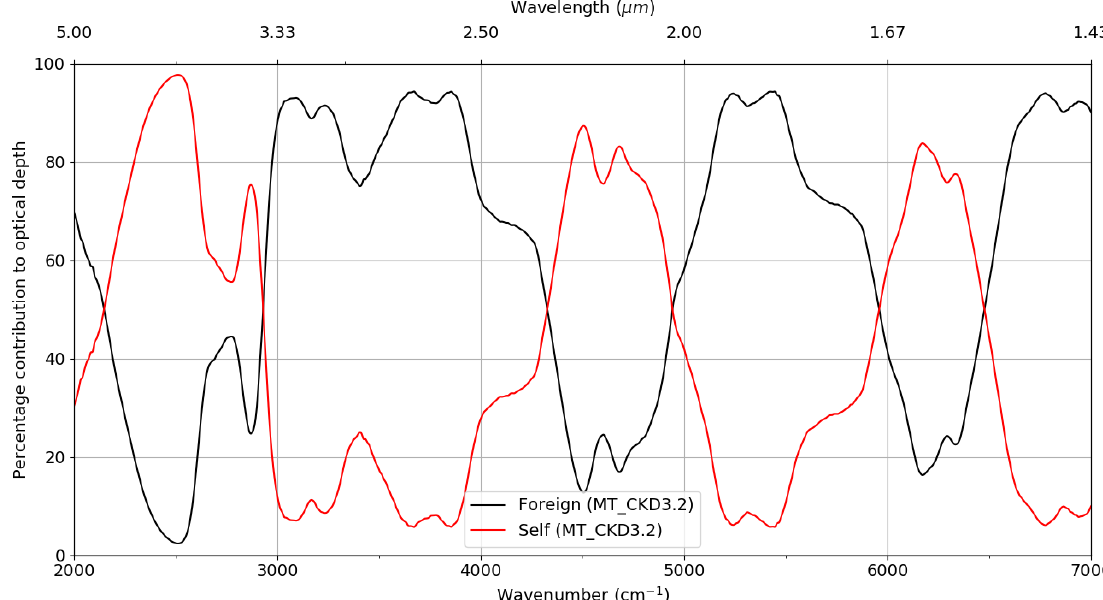
Figure 18. Proportion of the 18 September 2008 Camborne optical depth attributable to the self- and foreign-continua as calculated using the MT_CKD_3.2 model. The total optical depth is shown by the red line in Fig. 7.